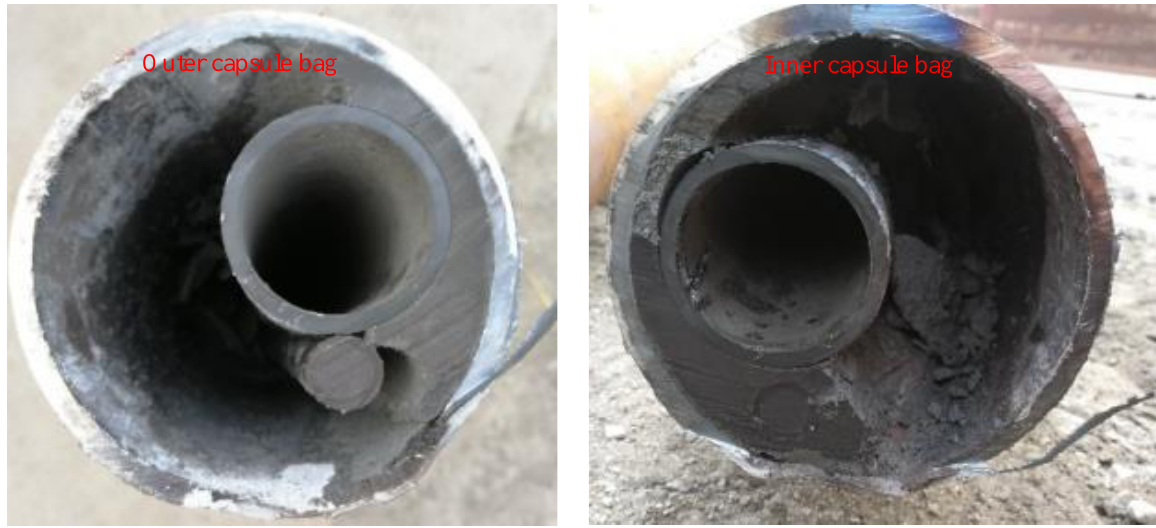
Figure 14. Borehole profile of boreholes for the “Two plugs and one injection” device .